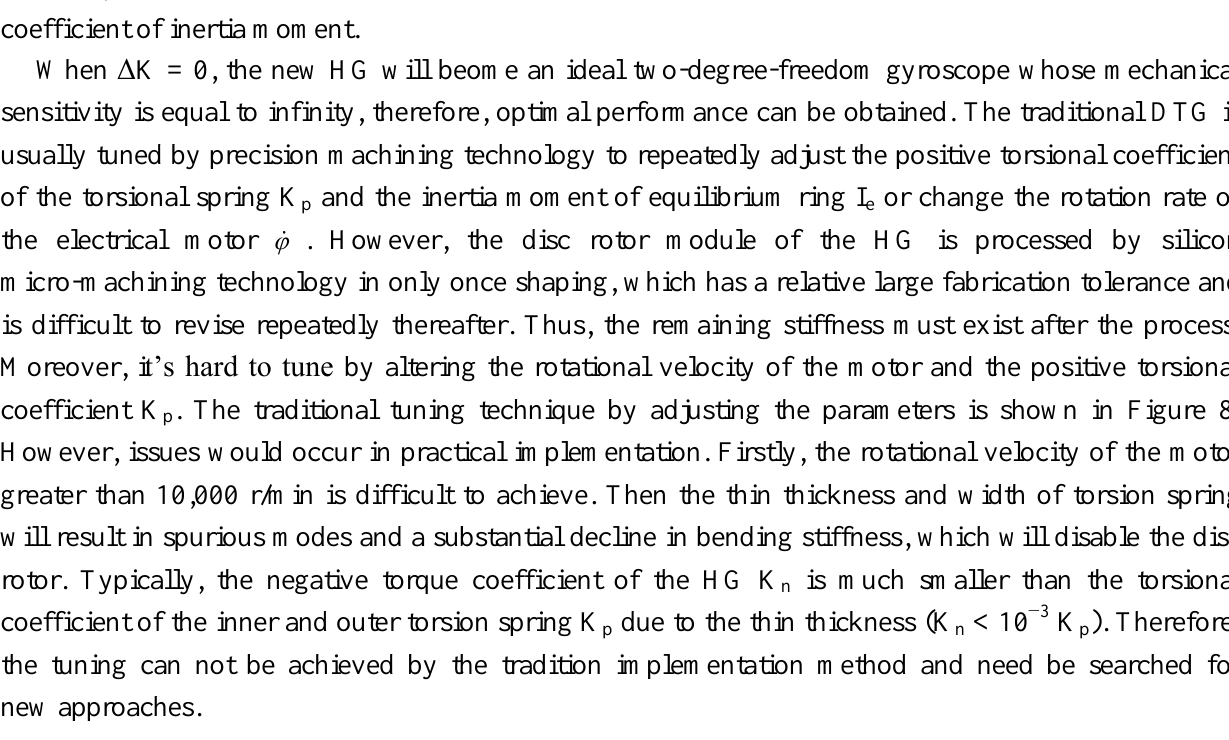
Figure 8. Traditional tuning technique by adjusting the parameters. ( A ) Adjusting the negative torque coefficient by changing rotational velocity. ( B ) Adjusting the positive torsional coefficient by changing the width of torsion